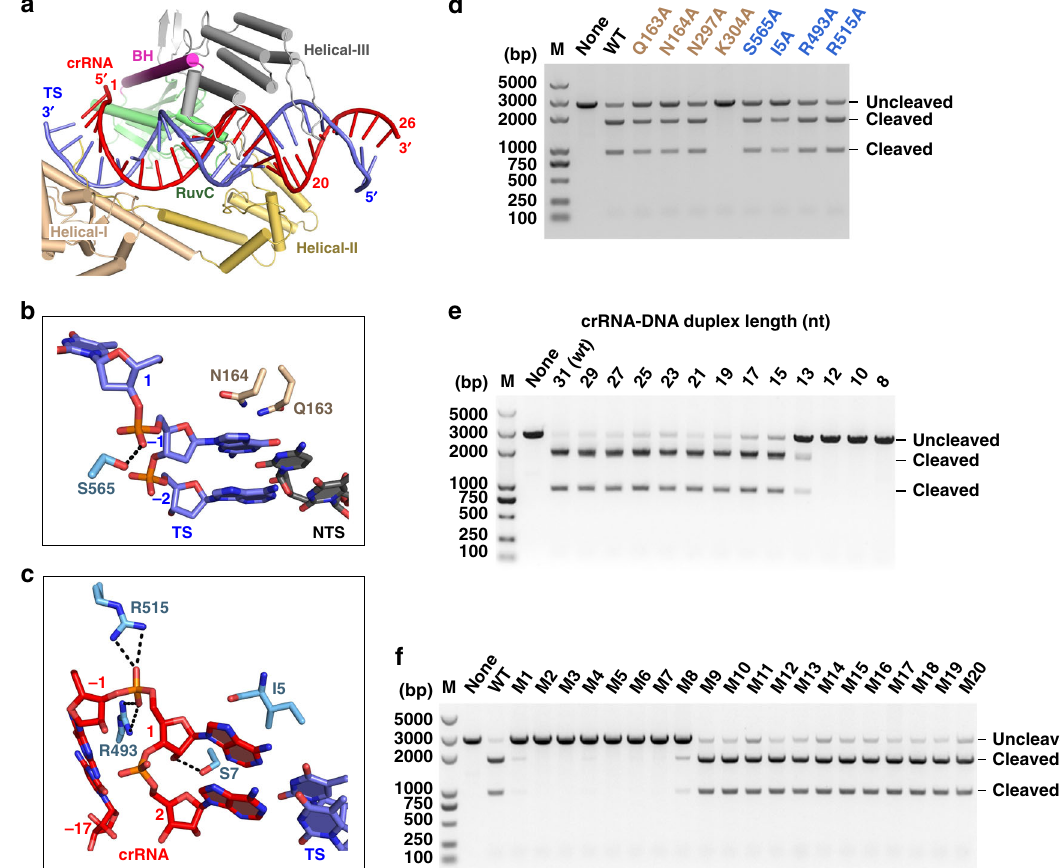
Fig. 2 The guide:target heteroduplex recognition. a The guide:target heteroduplex is located in the cleft between the REC and NUC lobes. b Magni fi ed view of interactions between Cas12i2 and nucleotide ( − 1) of the target dsDNA. c Interaction of the WED domain with the RNA:DNA hybride at position + 1. d Mutation of residues interacting with dsDNA or RNA:DNA duplex at position 1 – 2 impairs the DNA cleavage activity by Cas12i2. Linear plasmid DNA cleavage assay using the 300 ng linearized plasmid DNA as substrate in the presence of 200 nM mutants or wild-type Cas12i2 – crRNA complex at 37 °C for 15 min. e Linear plasmid DNA cleavage assay showing that the length of the guide:target heteroduplex affects the cleavage activity of Cas12i2. f Linear plasmid DNA cleavage assay using single mismatched target